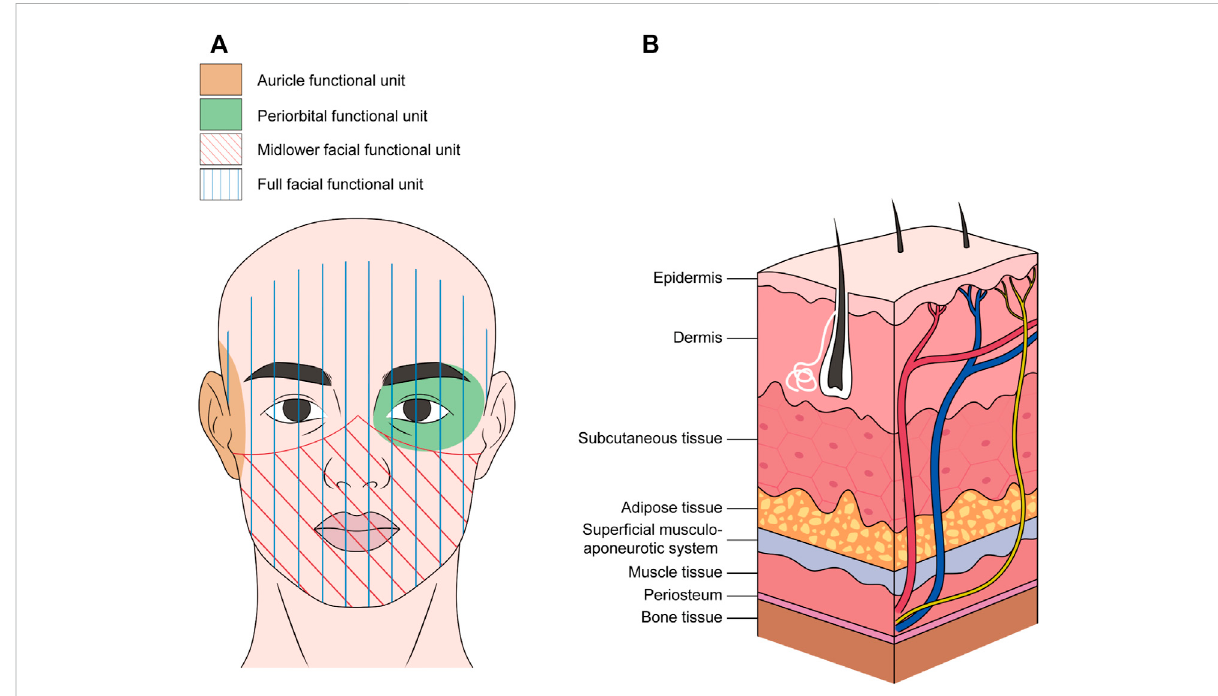
FIGURE 2 Common craniofacial allogeneic composite functional units (A) and tissue composition (B)